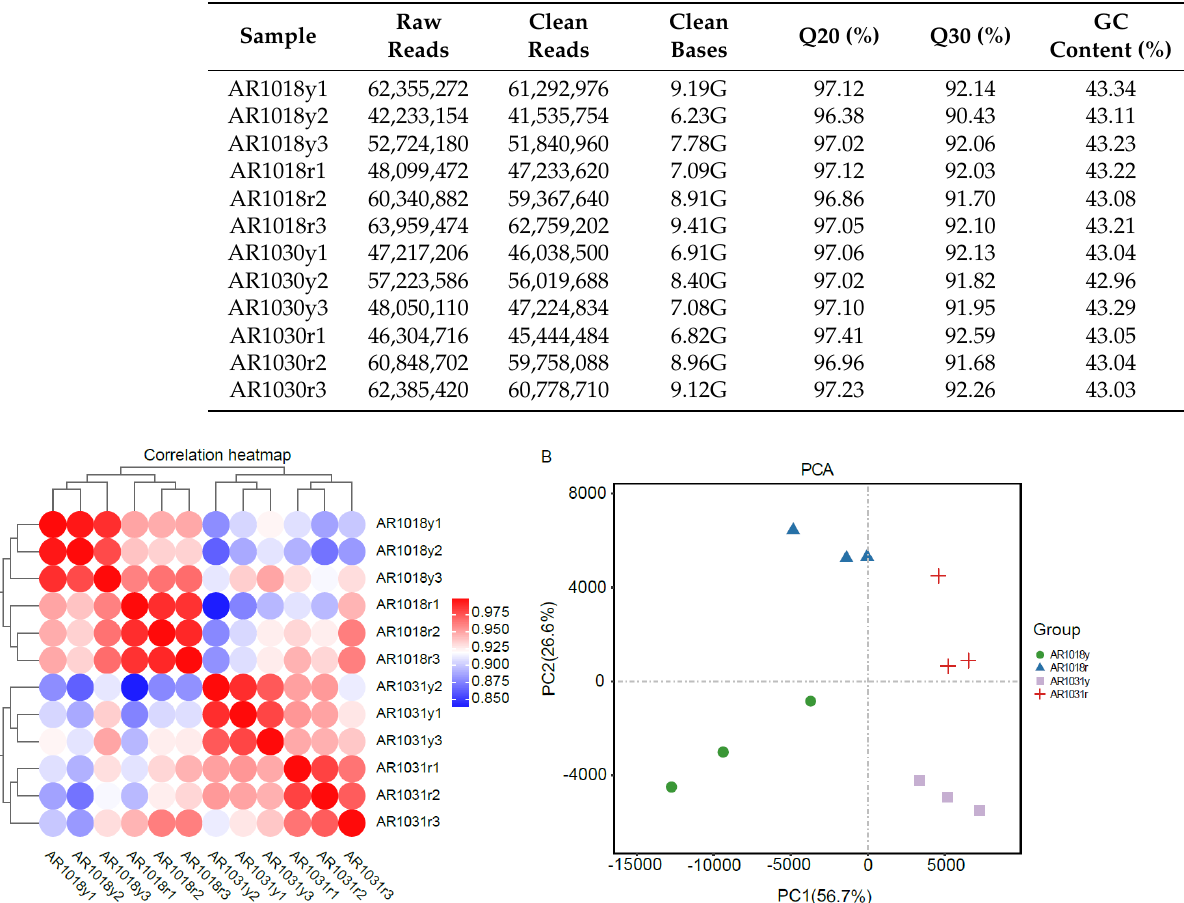
Table 1. Statistical analyses and mapping results of RNA sequencing reads.